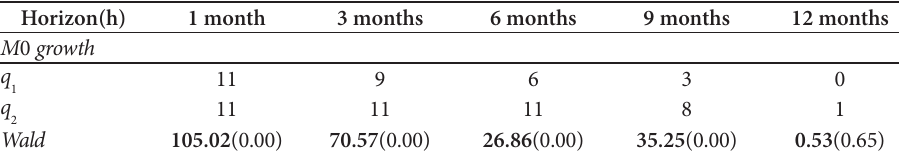
Table 1. Forecasting test results for the out-of-sample period Horizon(h) 1 month 3 months 6 months M 0